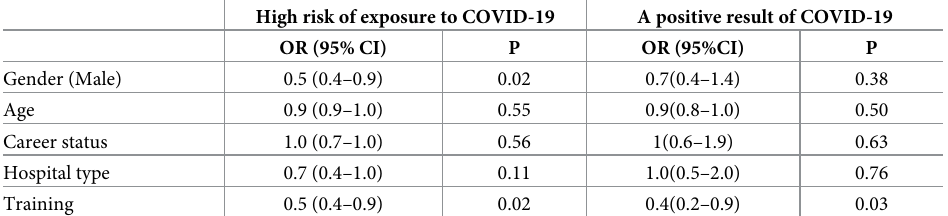
Table 4. Shows a binary logistic regression between high risks of exposure to COVID-19 and the positive result for the SARS-CoV-2and the independent